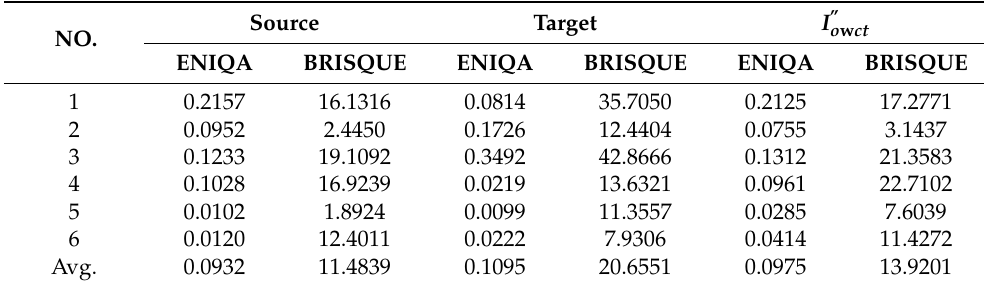
Table 9. No-reference image quality assessment for 6 test